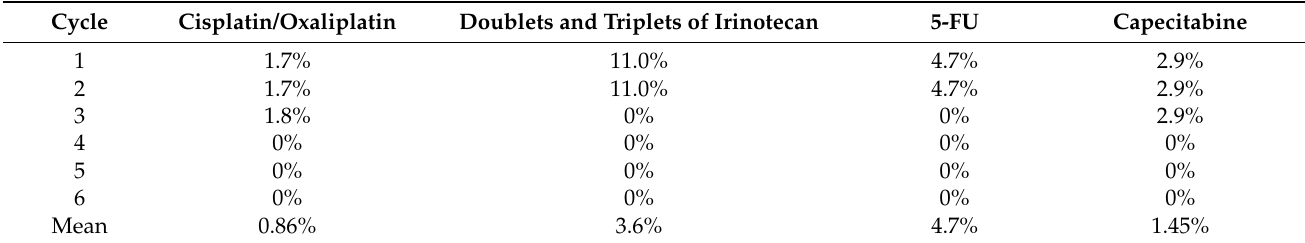
Table 3. Rates of grade 3–4 diarrhoea for different therapeutic agents and